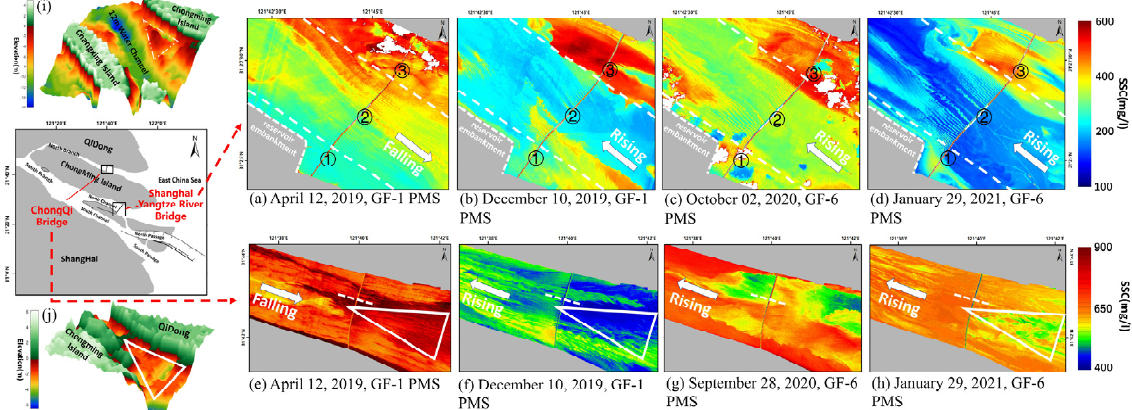
Figure 7. ( a – h ) SSC retrieved from the GF-6 PMS and GF-1 PMS images; ( i , j ) the underwater topography around the Chongqi Bridge and the underwater topography around the Shanghai Yangtze River Bridge.